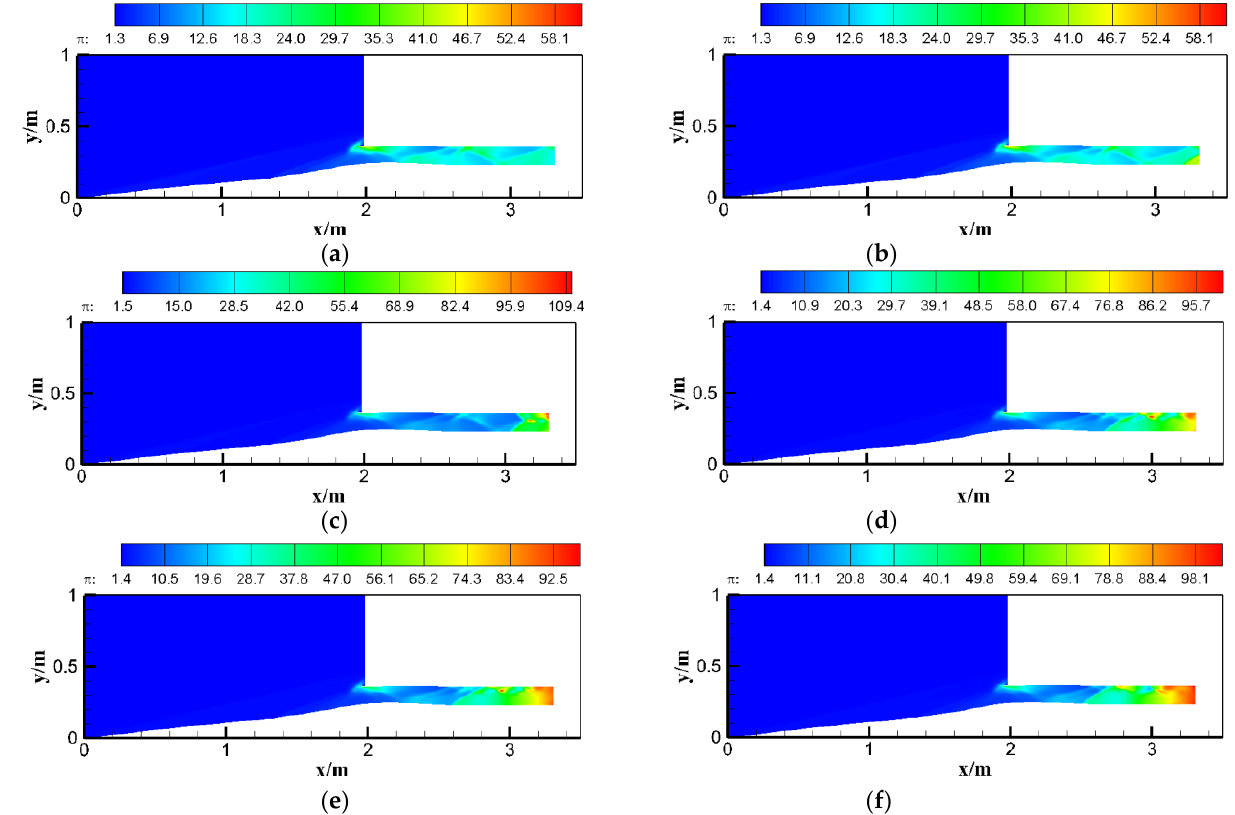
Figure 5. Pressure contours of the central-spillage integrated form under different backpressures (Form 1). ( a ) π b = 18.5, ( b ) π b = 37.9, ( c ) π b = 61.8, ( d ) π b = 83.3, ( e ) π b = 89.3, ( f ) π b = 99.6.